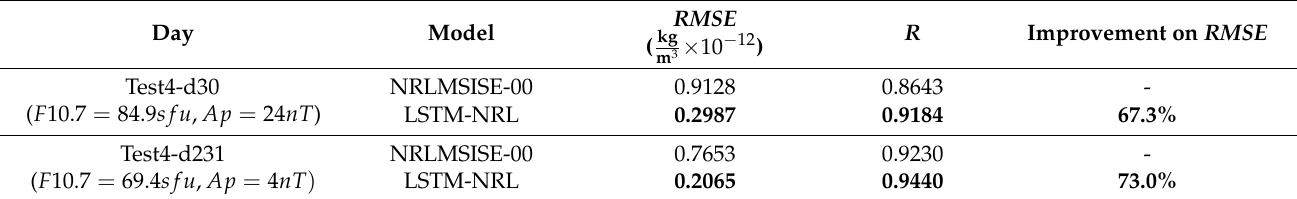
Table 5. The performance of the LSTM-NRL in Test 4. It is noted that the best results, in terms of RMSE and R , are bold in the table.